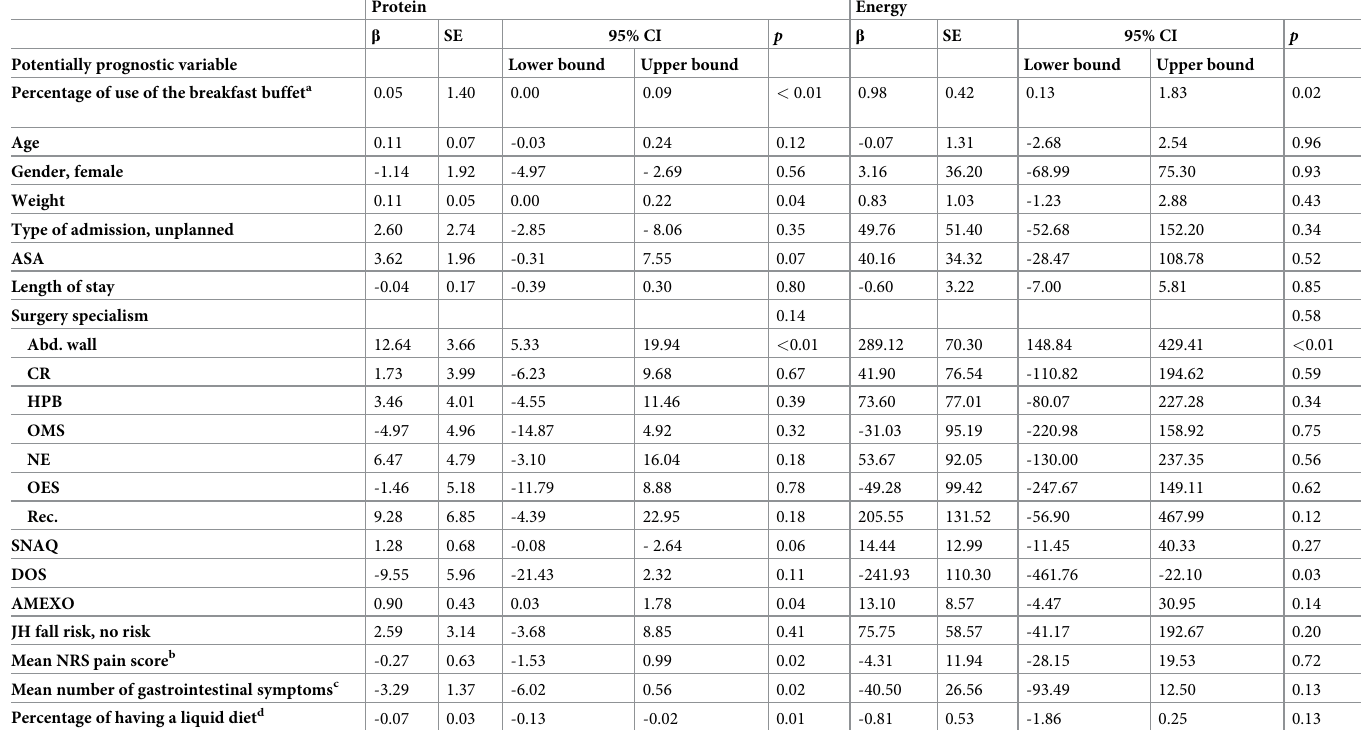
Table 3. The univariable relationship between potential prognostic factors and protein, energy intake. Protein Energy β SE 95% CI p β SE 95% CI p Potentially prognostic variable Lower bound Upper bound Lower bound Upper bound